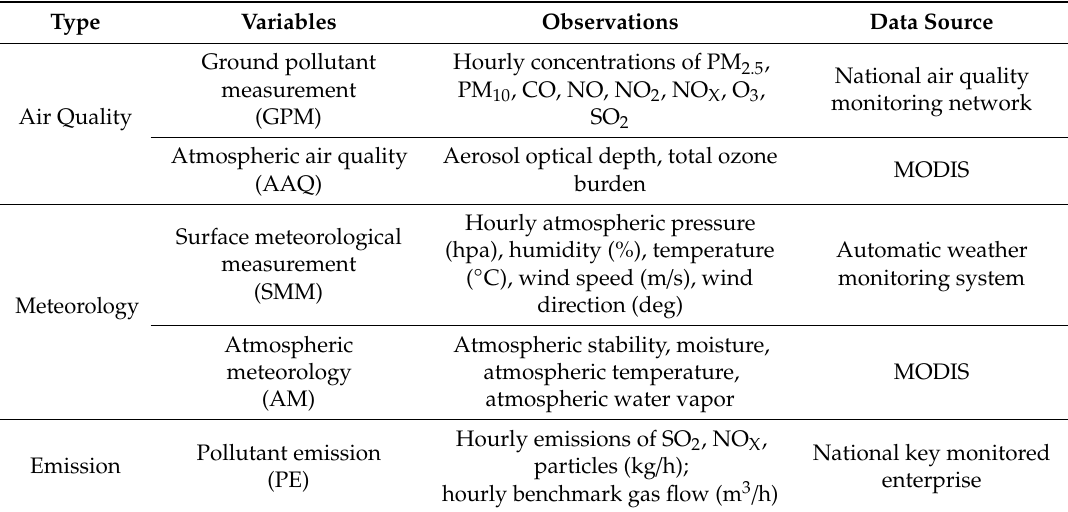
Table 1. Independent variables. Legend: PM 2.5 , particulate matter with an aerodynamic diameter of